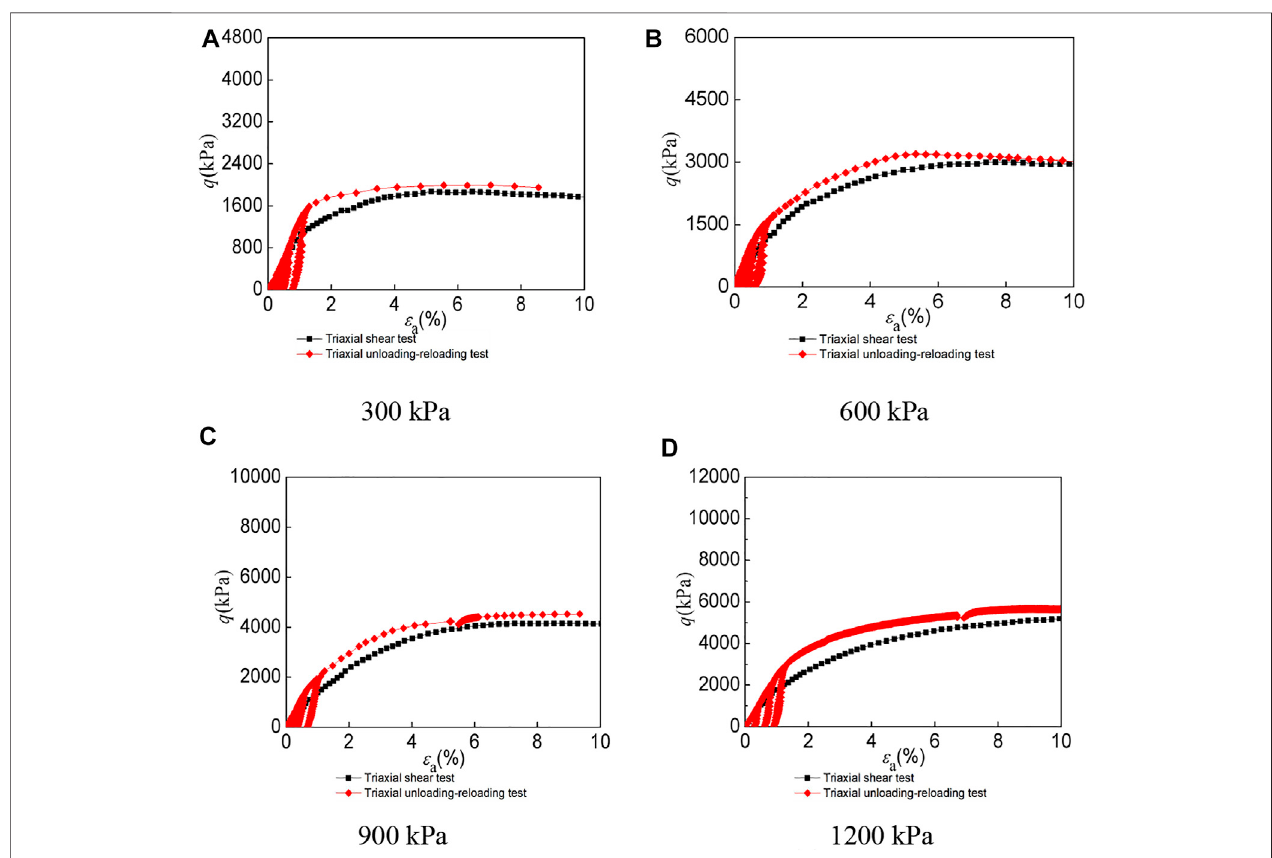
FIGURE 2 | Stress – strain curves of LCSG material with cemented content of 20 kg/m 3 under different con fi ning pressures. (A) 300 kPa (B) 600 kPa (C) 900 kPa (D) 1,200 kPa.